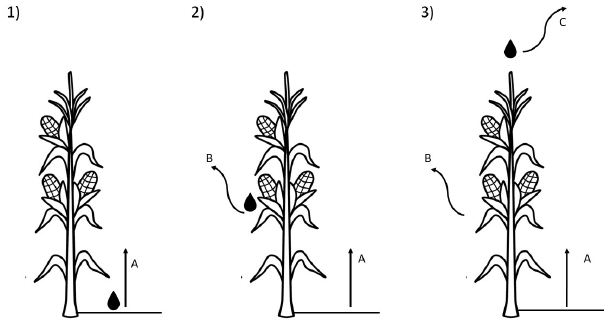
Figure 1. Irrigation schemes (1–3) with increasing evaporative pro- cesses considered (A–C): A is the evaporation from the water at the soil level, B is the canopy interception, and C is the drop evap- oration and drift. This framework accounts only for surface water application and not